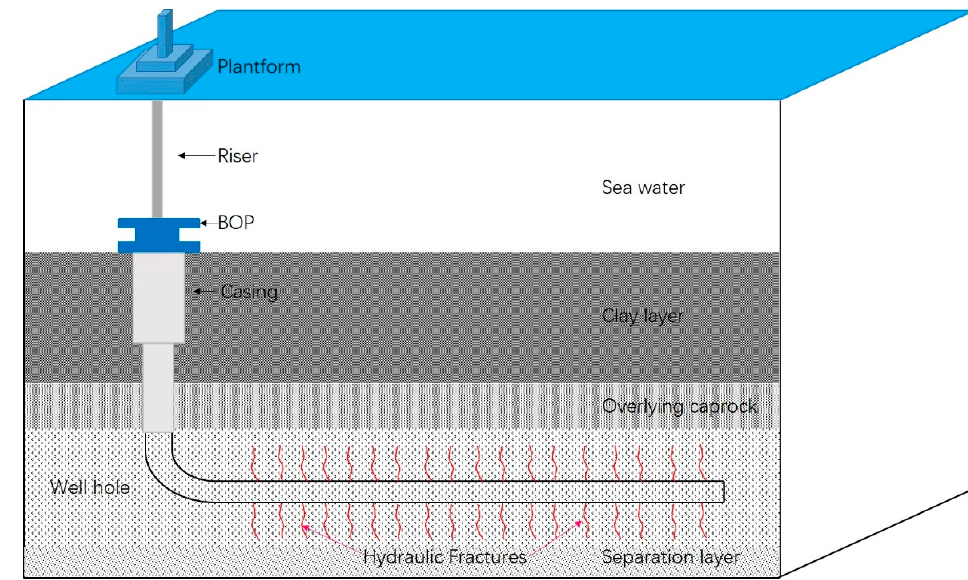
Figure 3. Schematic diagram of physical model for horizontal well fracturing.